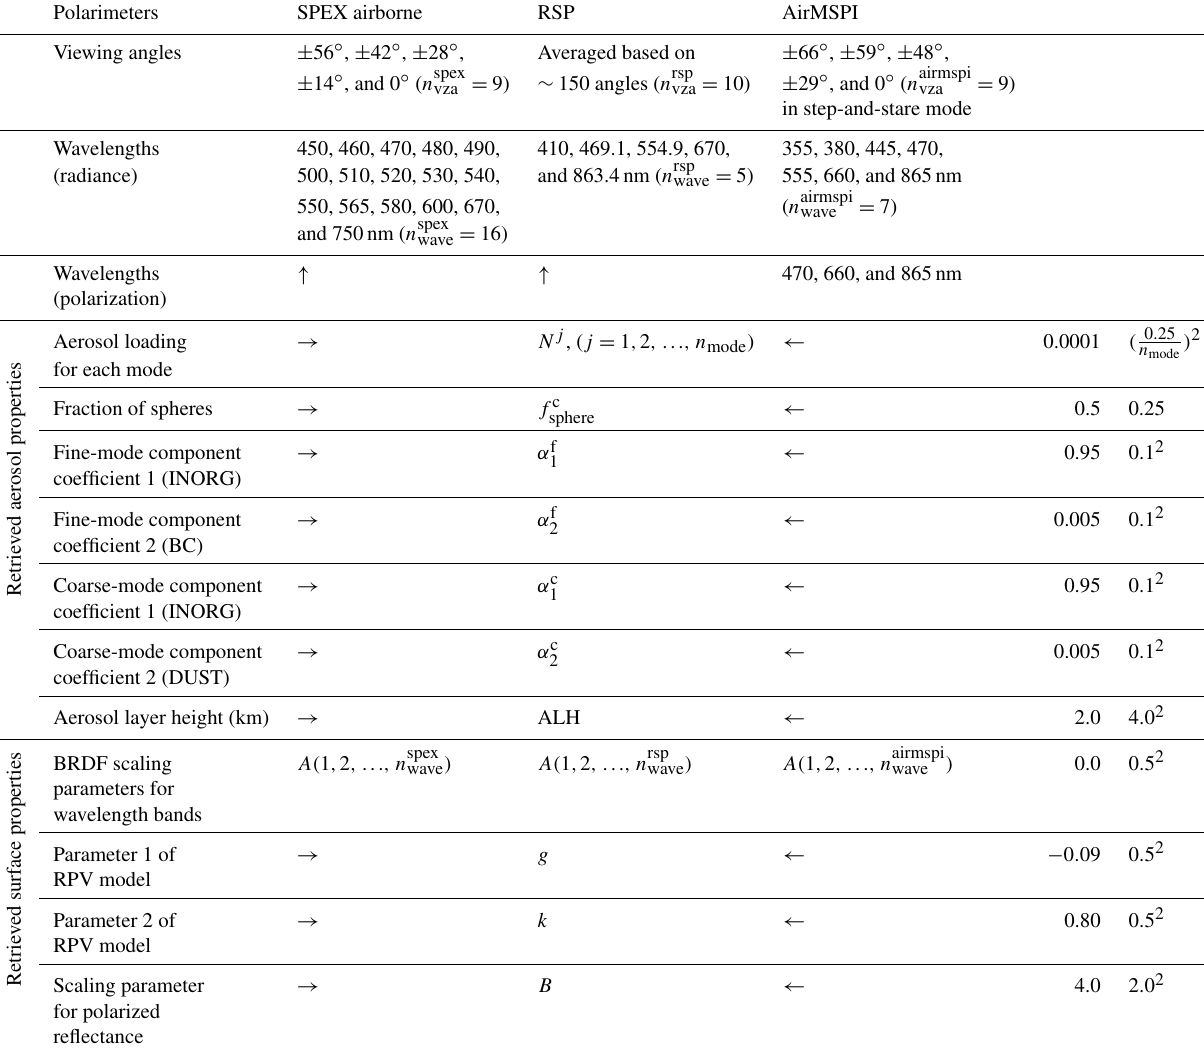
Table 2. Viewing angles and wavelengths used in retrievals among SPEX airborne, RSP, and AirMSPI, as well as the retrieved parameters from them. Prior values and weighting factors for the state vector are also listed in the table. In this paper, five-mode retrieval is used, and thus n mode = 5. The arrows → , ← , or ↑ indicate the same value with the arrow direction. The prior value and weighting factor of aerosol loading for each mode are calculated based on Mie theory using the prior information of AOD from the table (listed in the row of aerosol